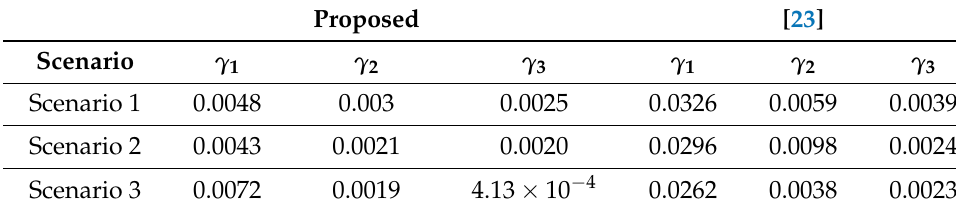
Table 2. Mean square errors of γ 1 ( t ) , γ 2 (t), and γ 3 ( t ) at the steady-state response.